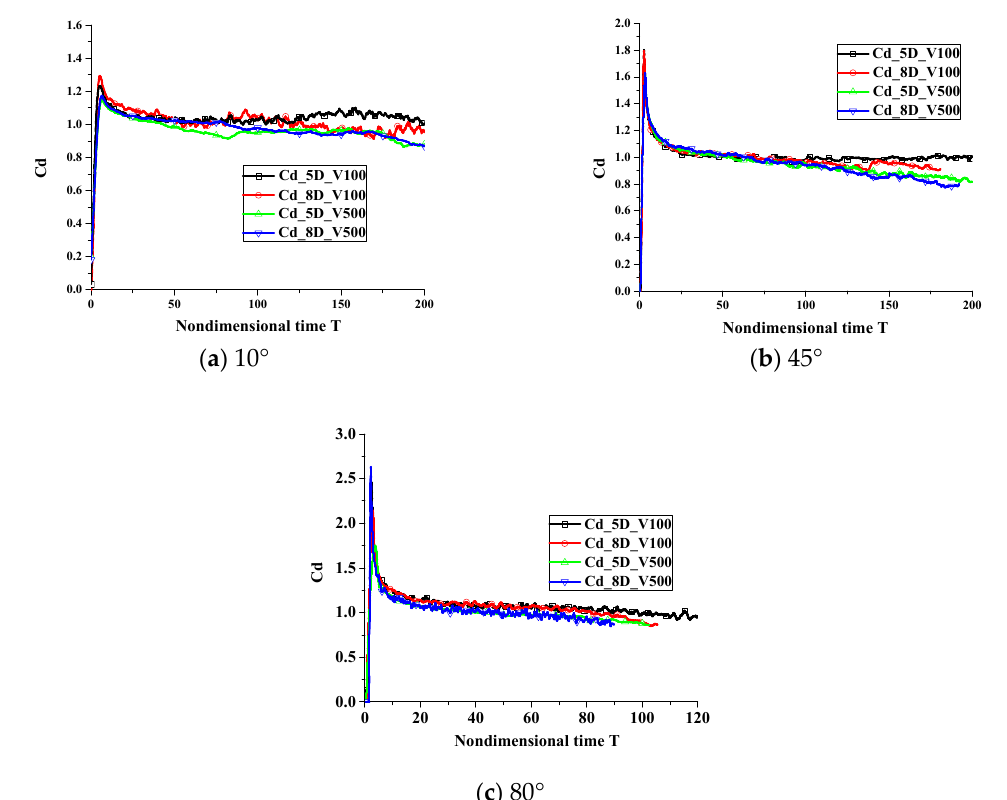
Figure 9. Drag coefficients of water entry for different initial inclination angles: ( a ) 10°, ( b ) 45°, ( c ) 80°.